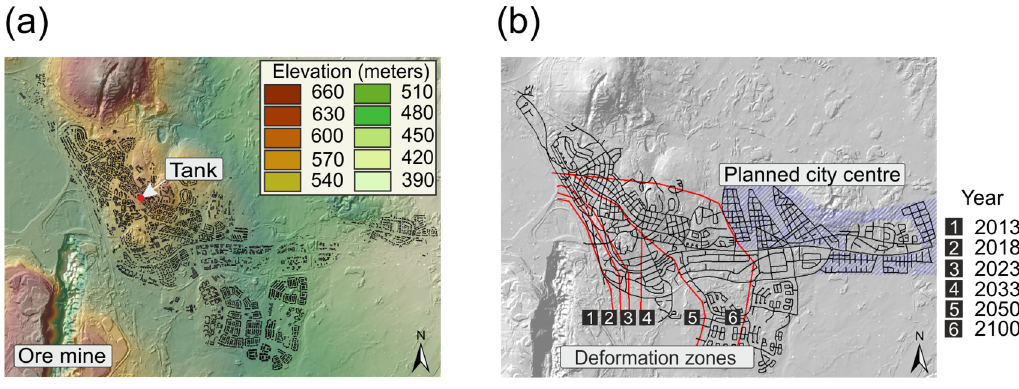
Figure 5. ( a ) Current Kiruna with digital elevation map (DEM); ( b ) Current and future street networks (planned) with the step-by-step expansion of deformation zones, according to the master plan.